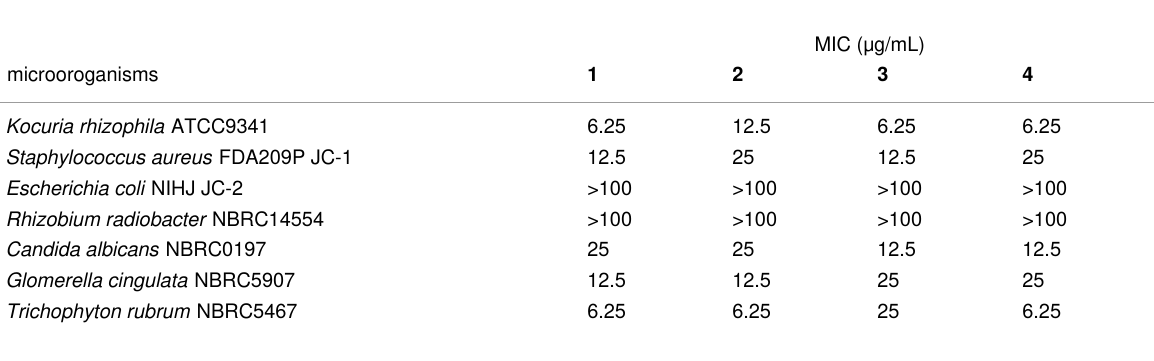
Table 2: Antimicrobial activity of the nocarimidazoles 1 – 4 .